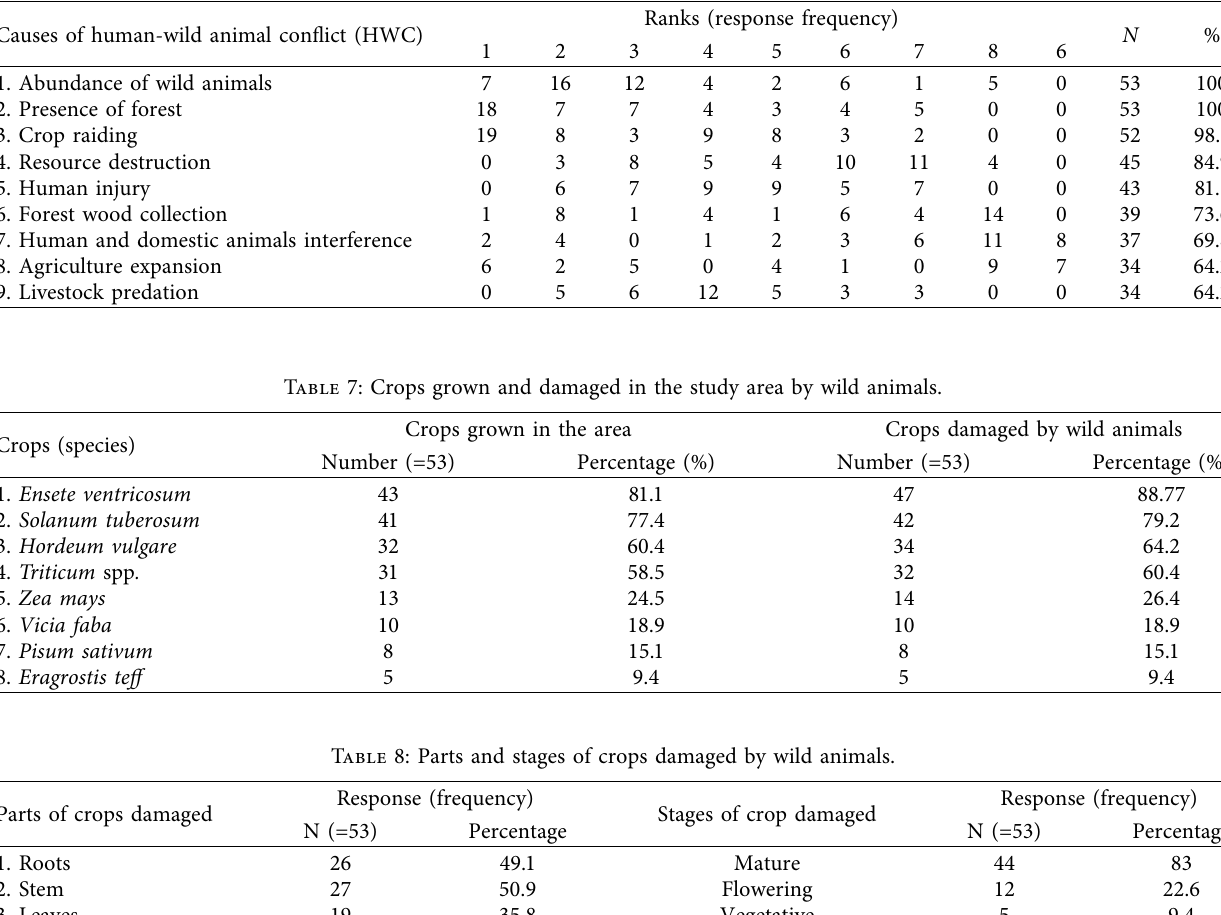
Table 6: Cause of human-wild animals conflict.